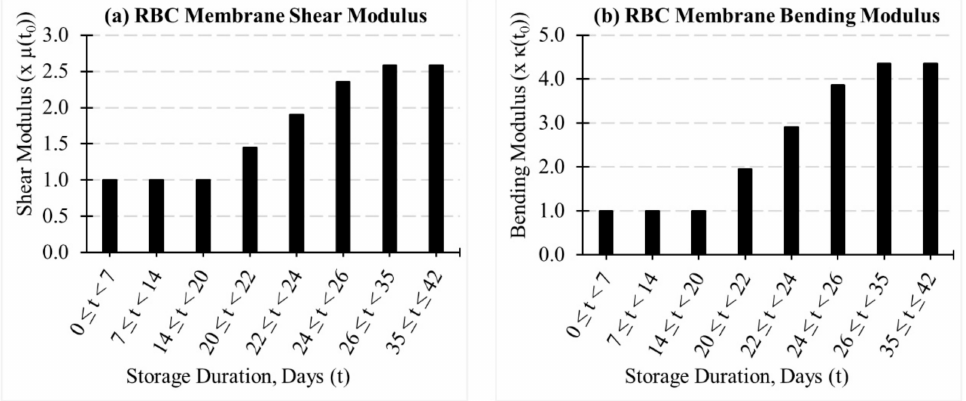
Figure 2. The evolution of the Coarse-Grained (CG)-RBC membrane: ( a ) shear modulus ( µ ( t ) ) and ( b ) bending modulus ( κ ( t ) ) during in-vitro storage. µ ( t ) and κ ( t ) are presented in the form of multiplications of µ ( t 0 ) and κ ( t 0 ) ,